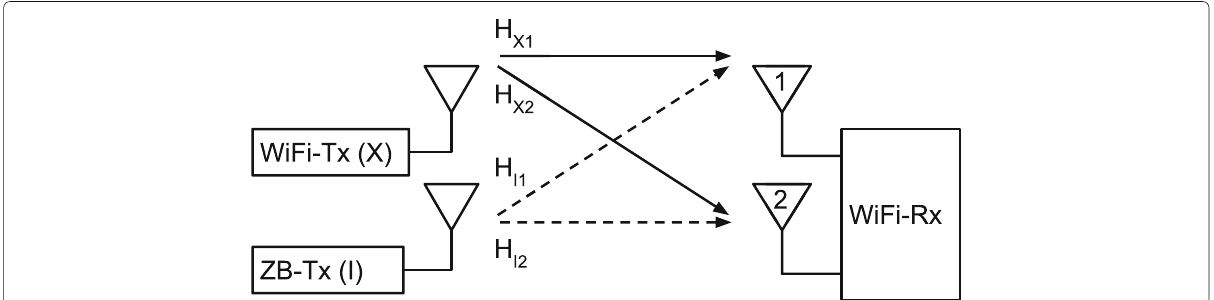
Fig. 7 Signal model: single-antenna WiFi transmitter, single-antenna ZigBee interferer and two-antenna WiFi receiver